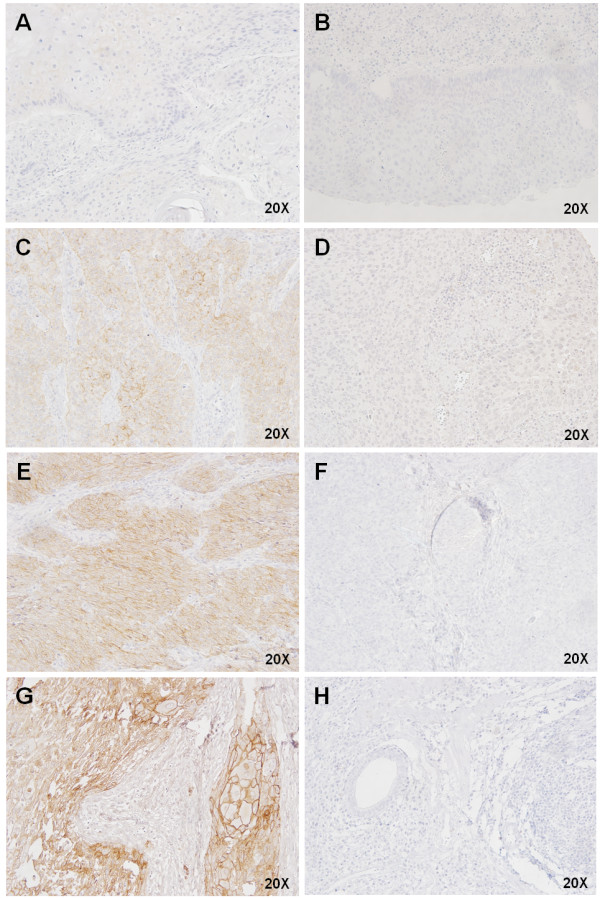
Expression of HER2 in ESCC by immunohistochemistry. (A) Representative image of HER2 negative score in ESCC, and (B) its corresponding negative control. (C) Representative image of HER 2 Score 1+ in ESCC, and (D) its corresponding negative control. (E) Representative image of HER 2 Score 2+ in ESCC, and (F) its corresponding negative control. (G) Representative image of HER 2 Score 3+ in ESCC, and (H) its corresponding negative control.